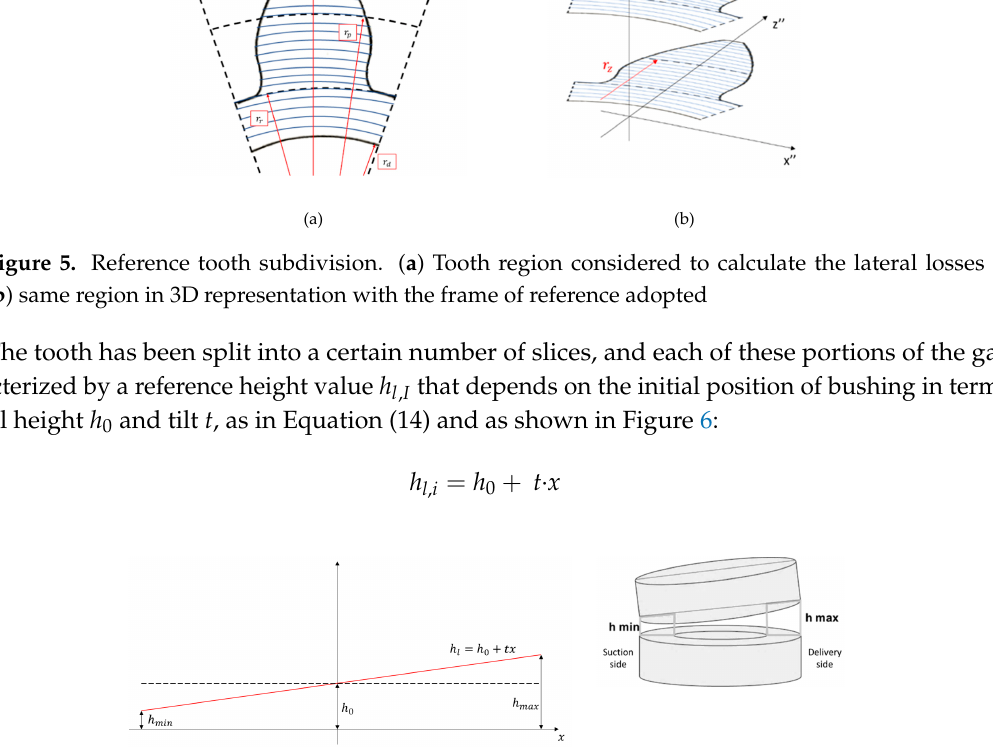
Figure 4. Qualitative pressure distribution in the journal bearing (gear shaft-bushing blocks gap).